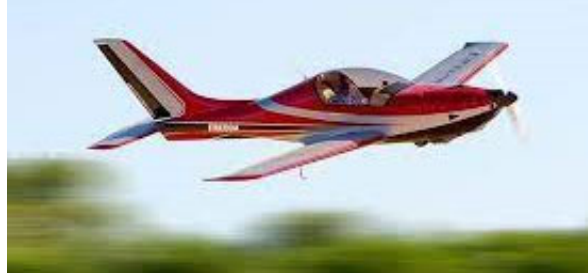
Figure 2. Reference aircraft (Promecc Aerospace Freccia).